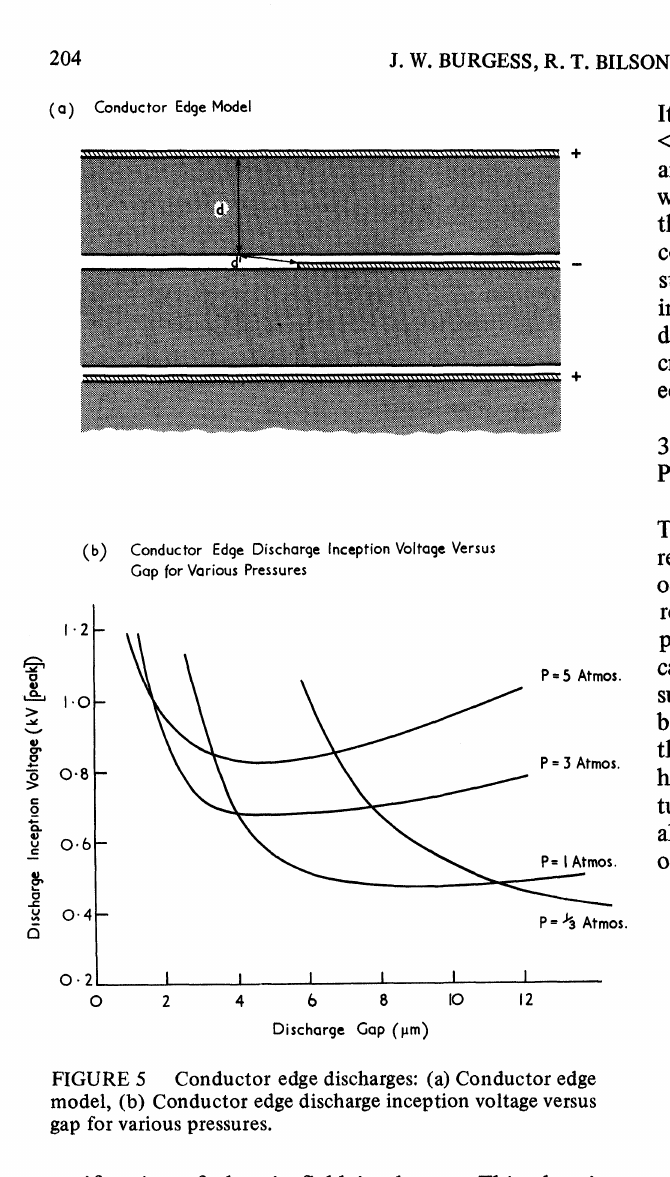
FIGURE 5 Conductor edge discharges: (a) Conductor edge model, (b) Conductor edge discharge inception voltage versus gap for various pressures.